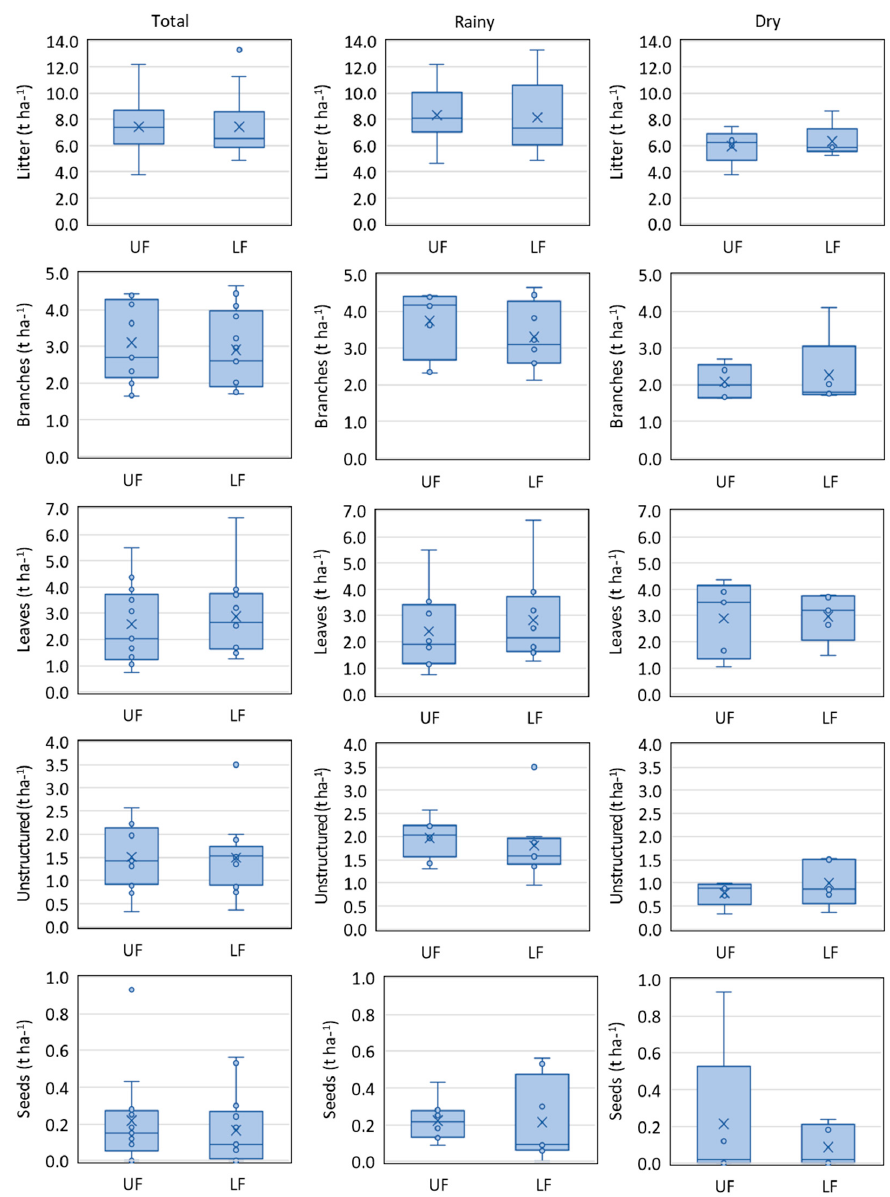
Figure 2. Monthly li tt er and fractions accumulation (dry mass) for total period, rainy and dry sea- sons at unlogged (UF) and logged forest (LF), Jamari National Forest, Rondônia—Brazil. at unlogged (UF) and logged forest (LF), Jamari National Forest, Rond ô